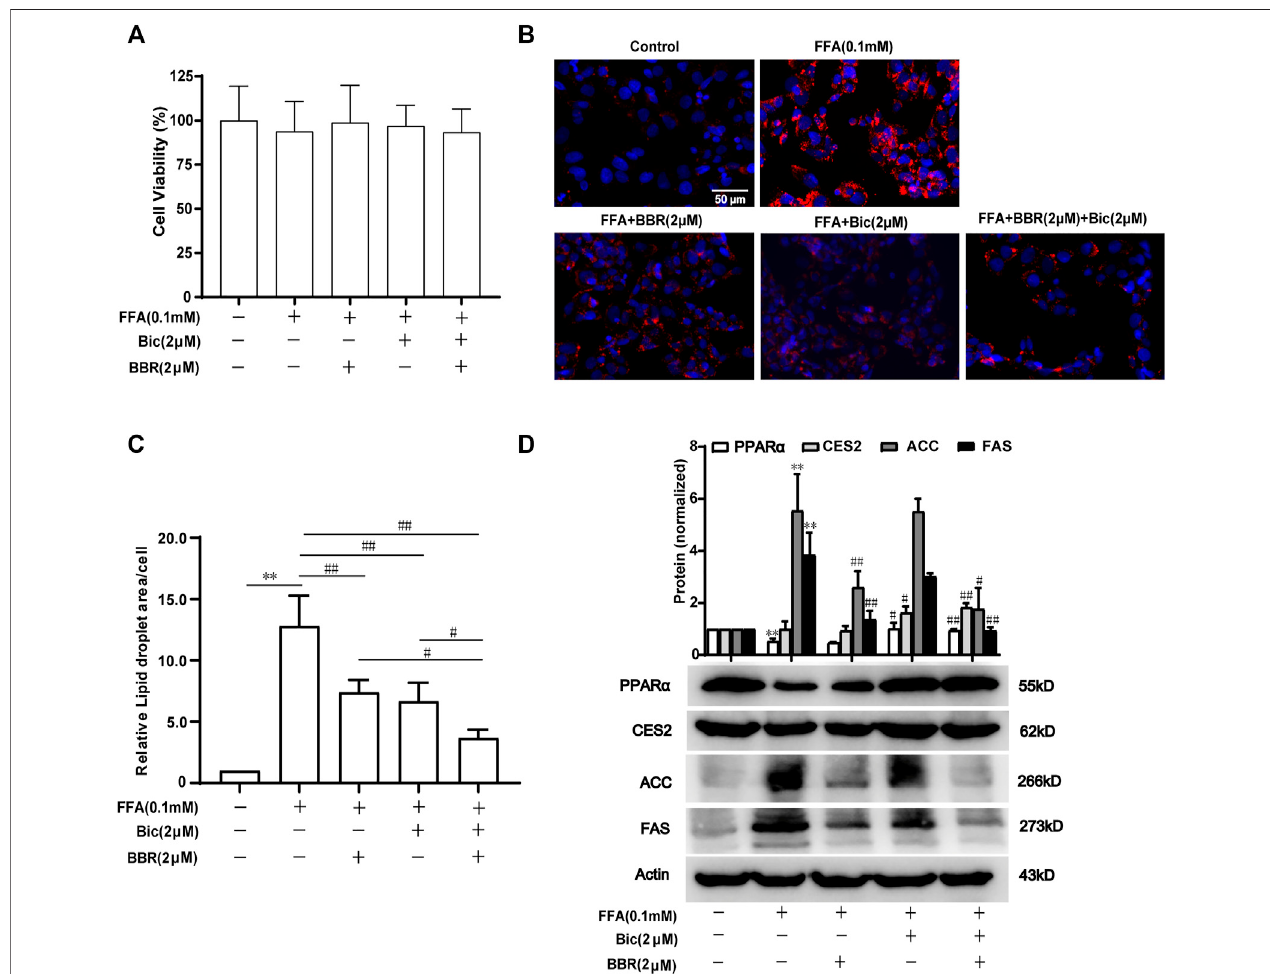
FIGURE 6 | Combined use of bicyclol and berberine decreases lipid accumulation via regulating lipid metabolism-related gene expression in FFA-induced HepG2 cells. HepG2 cells were induced by 0.1 mM FFA and simultaneously treated for 24 h with 2 μ M berberine, 2 μ M bicyclol, or their combinations. The cells were assayed with an MTT method to show the cytotoxicity (A) , or carried out Nile Red staining to show LDs (B) and the level of LDs in cells were quanti fi ed using Image-Pro Plus 6.0 (C) . Total proteins were extracted and detected with Western blot (D) . n ≥ 3, **p < 0.01, the model group vs. control group; # p < 0.05 and ## p < 0.01 vs. the model group or the monotherapy group. FFA, free fatty acid; LDs, lipid droplets; PPAR α , proliferator-activated receptor α ; CES2, carboxylesterase 2; ACC, acetyl-CoA carboxylase; FAS, fatty acid synthase.